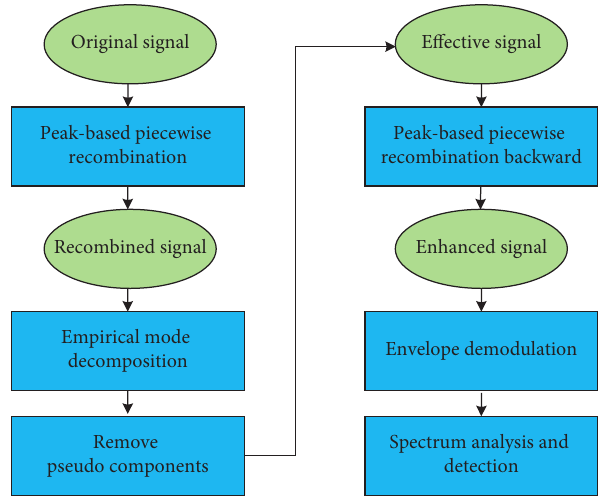
Figure 2: Flowchart of the proposed enhancement scheme for the weak fault